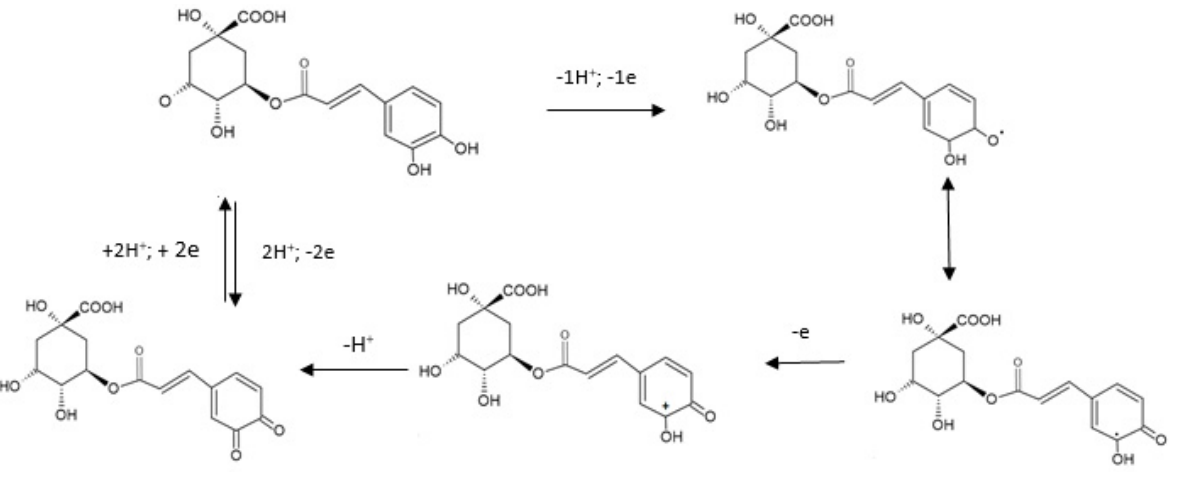
Figure 4. Electrochemical oxidation mechanism of CGA [58].